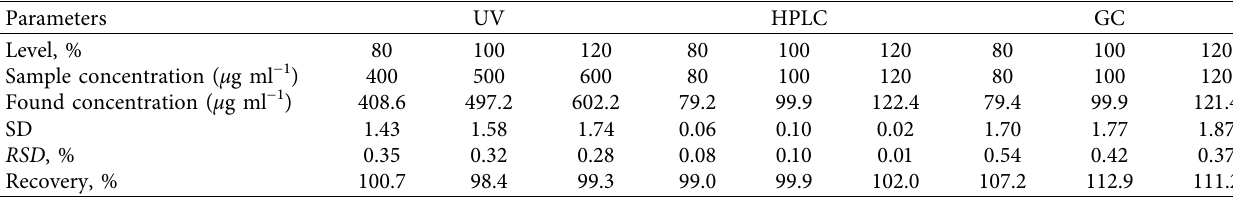
Table 4: Criteria of accuracy of BAC determination in the “VIROSAN F”.